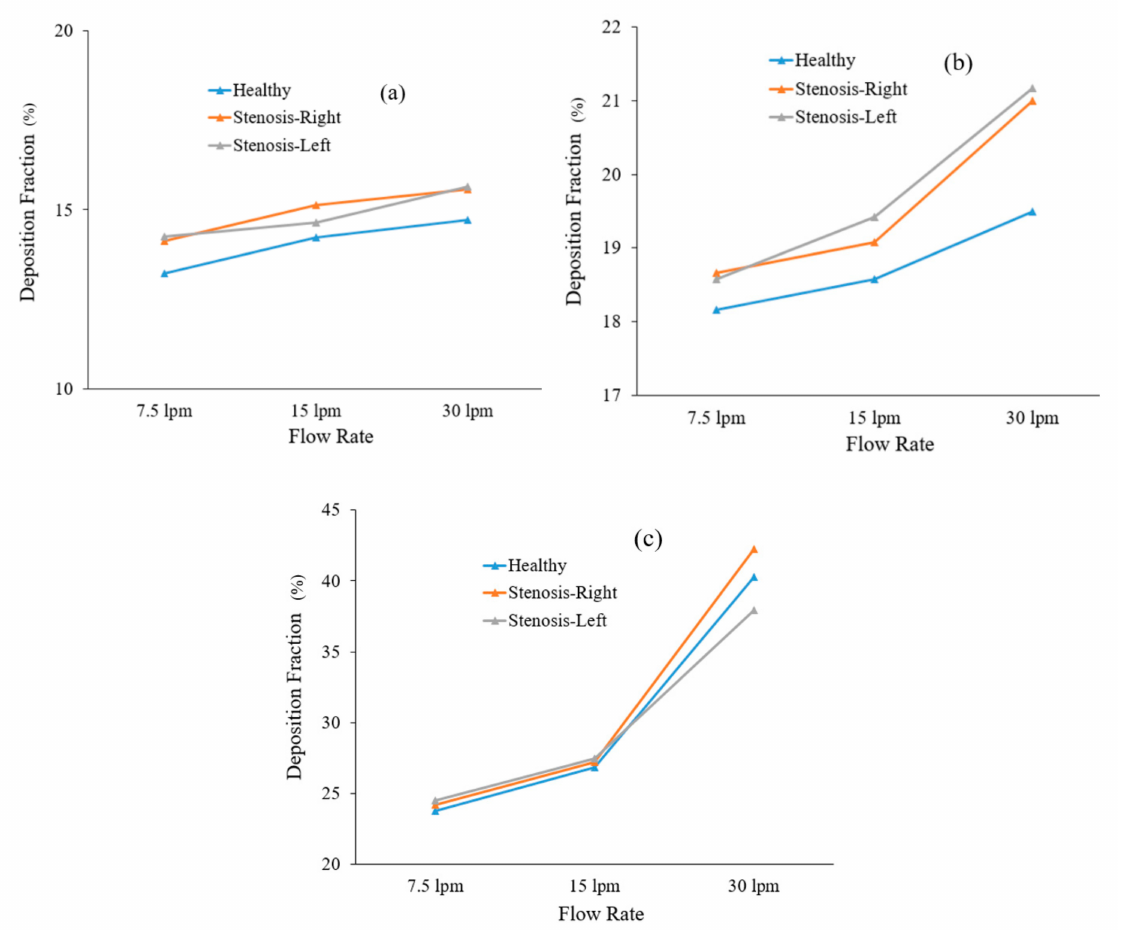
Figure 15. Deposition fraction of di ff erent-diameter particles in healthy and stenosis airways: ( a ) 2.5 µ m diameter, ( b ) 5 µ m diameter, and ( c ) 10 µ m